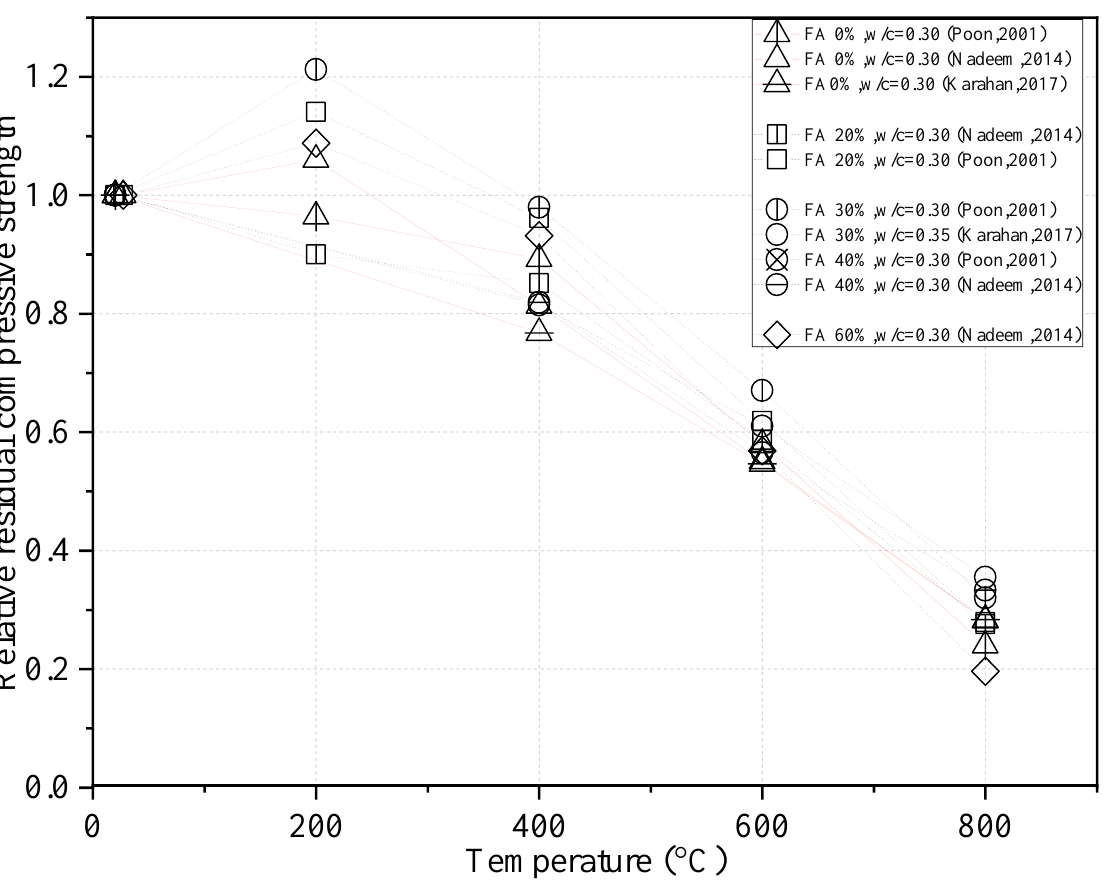
Figure 6. The relative residual compressive strength of concrete containing fly ash (FA) at different water – cementitious materials ratios (w/c) [35,39,42].